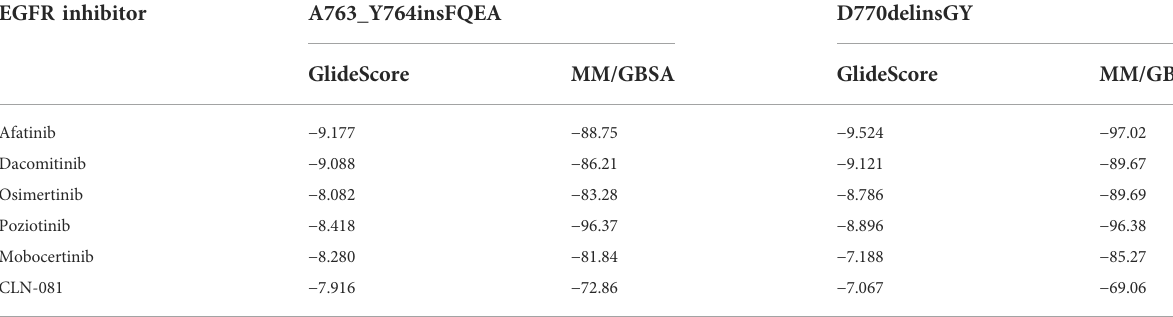
TABLE 3 Binding free energy (kcal/mol) of different EGFR inhibitors for A763_Y764insFQEA and D770delinsGY insertions. EGFR